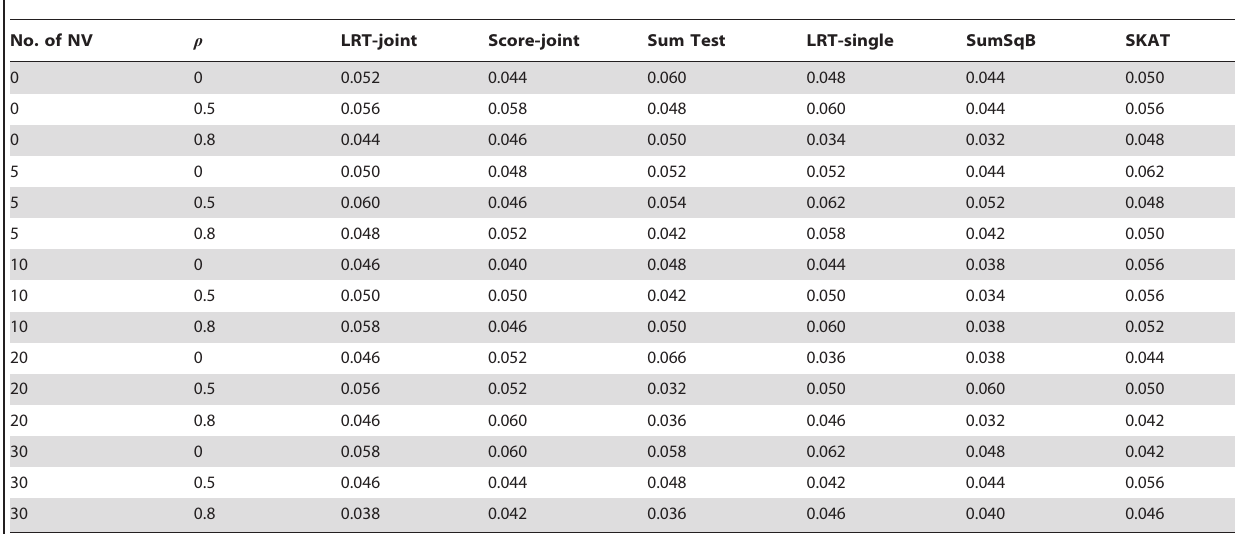
Table 4. Type I error rate for all tests: binary trait, a ~ 0 : 05 .